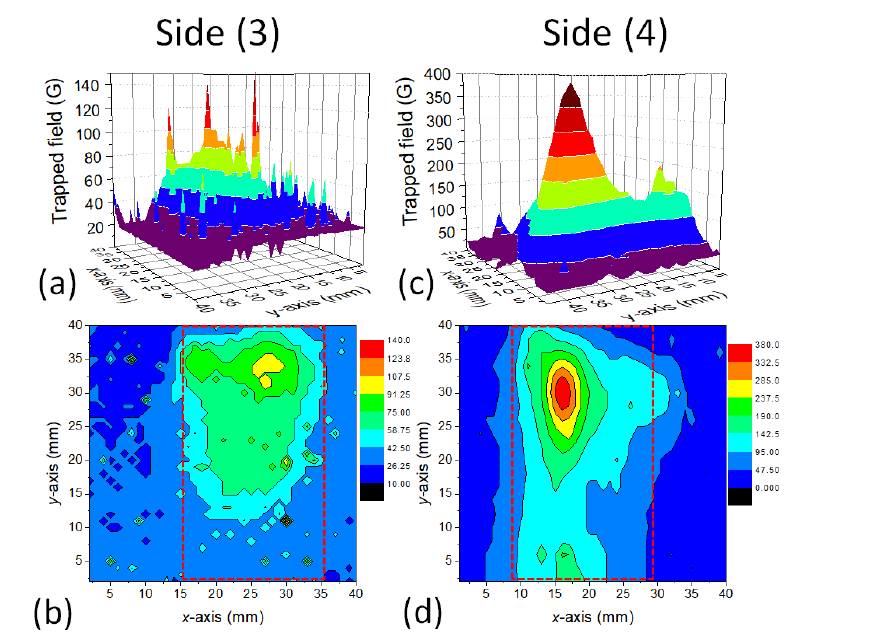
Figure 4. Trapped field measurements on a foam sample. Distribution of B z measured by scanning Hall probe on the sample Sides (3) and (4) of the foam as surface plots ( a , c ) and contour plots ( b , d ). ( a , b ) present the data of sample Side (3), ( c , d ) sample Side (4). The sample position is marked in the contour plots by a dotted red